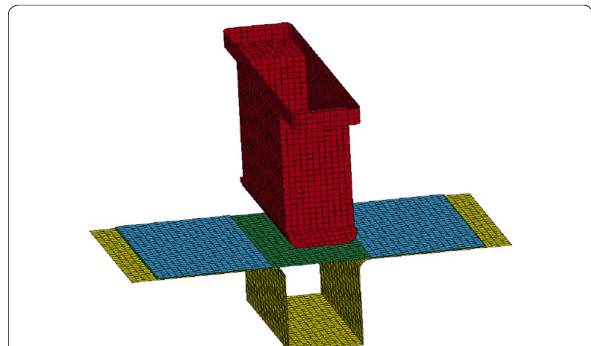
Figure 10 Finite element model